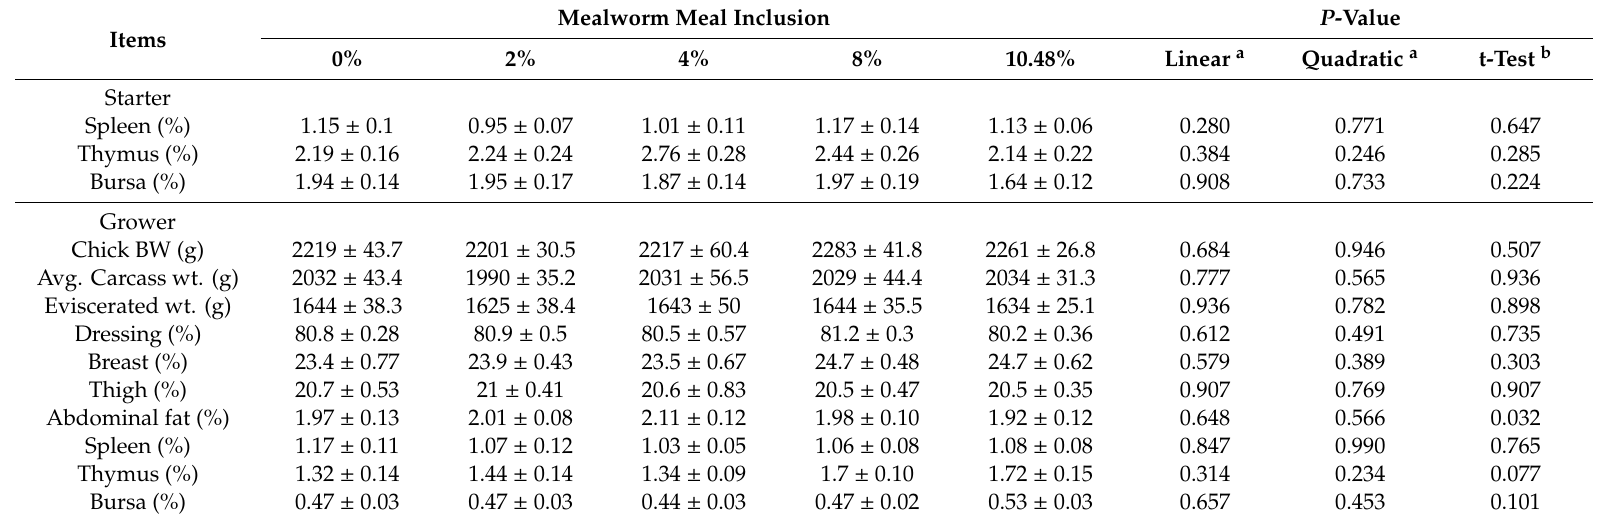
Table 5. Carcass quality of the broiler chicks fed on the MWM